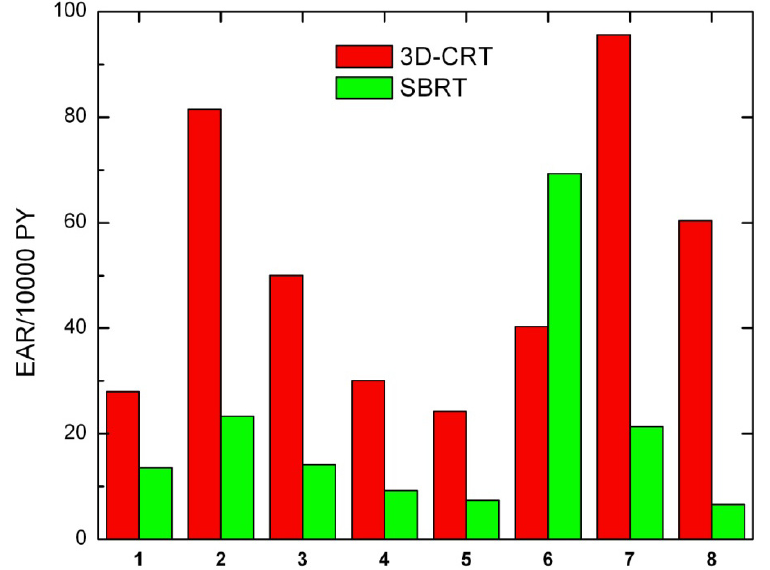
Figure 4. Excess absolute cancer risk for all solid tumors, for all